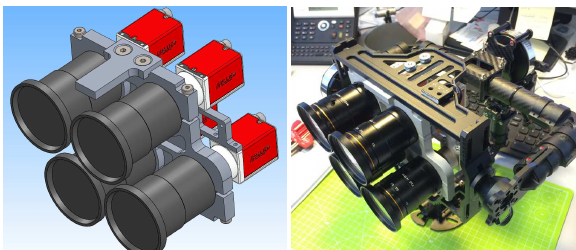
Figure 7. Left: CAD drawing of a four channel, multispectral imager (PanX). Right: Assembled prototype mounted in a stabilization